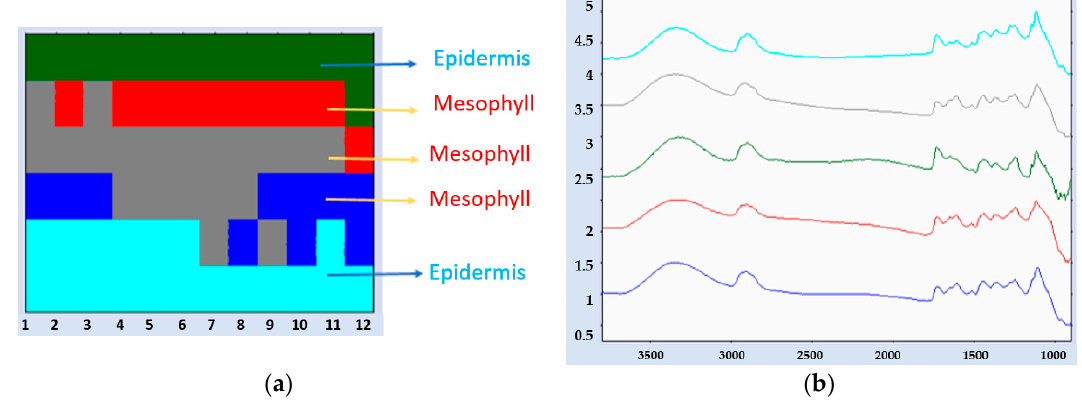
Figure 2. Fourier transform infrared (FTIR) mapping of rubber tree plantation. Hierarchical cluster analysis (HCA) was performed to determine the separation of spectral groups according to the composition within rubber leaf tissues. ( a ) The map consists of mesophyll layers (red, gray, blue) and epidermis layers (green and light blue). ( b ) 2D HCA mapping was produced using 2 clusters in the range of 4000–900 cm − 1 .